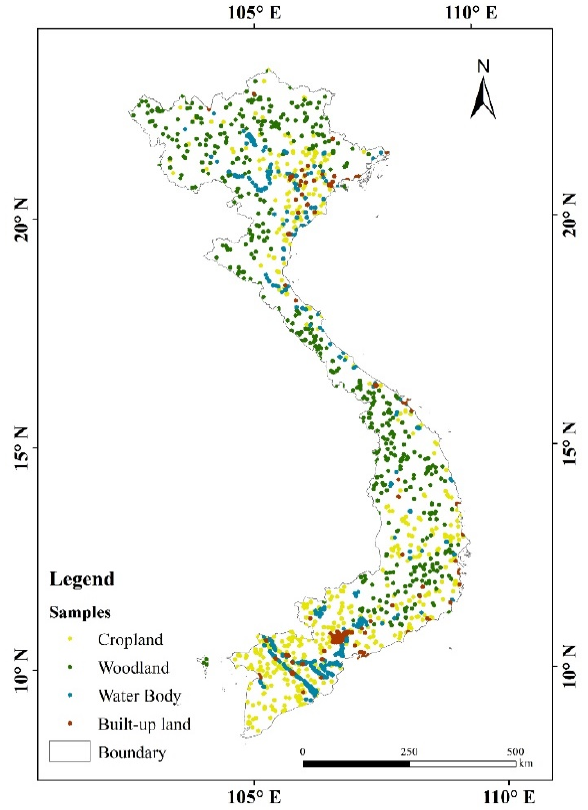
Figure 3. Distribution of sample points in the study area.